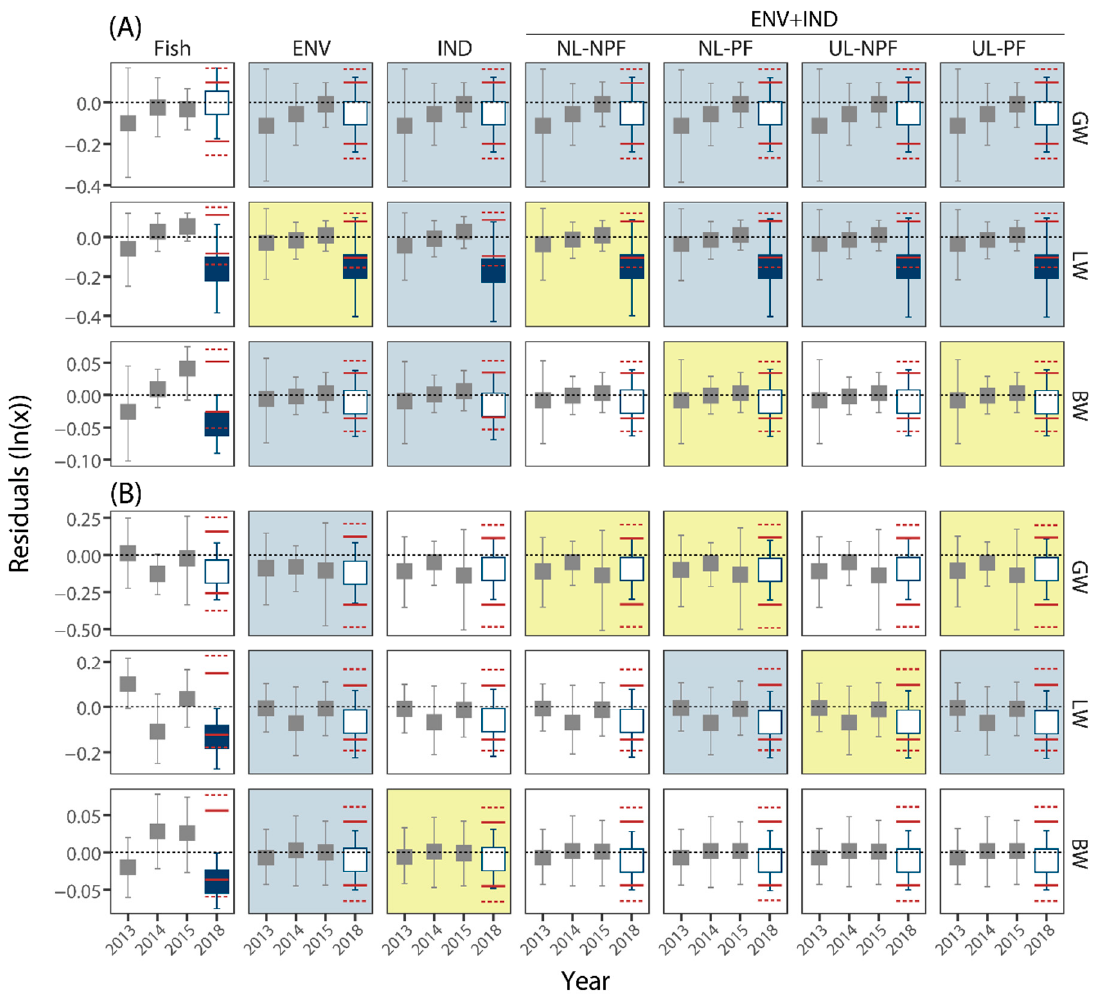
Figure 3. Mean residuals of male endpoints measured at the Upper Ells ( A ) and Lower Ells ( B ) locations; 2013–2015 (gray symbols) are reference years; 2018 is test year; red horizontal dashed and solid lines show expected ranges of mean residuals in 2018 given the reference data; open symbols suggest no difference in mean residuals; closed symbols suggest a difference in 2018; ‘Fish’ panes include models with no environmental or industrial covariates; ‘ENV’ includes environmental covariates only; IND includes industrial covariates only (with no limits and no penalty factors); ENV+IND with no limits and no penalty factors (NL ‐ NPF); ENV+IND with no limits and penalty factors (NL ‐ PF); ENV+IND with upper limits and no penalty factors (UL ‐ NPF); ENV+IND with upper limits and penalty factors (UL ‐ PF); blue shading of panes shows the most parsimonious models identified by AIC; yellow shading indicates marginally relevant models selected by AIC.